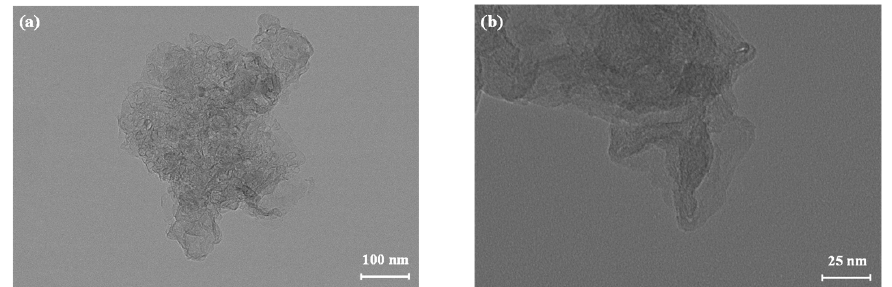
Figure 1. Representative TEM micrographs of S 3 N 3 − GF ( a , b ).